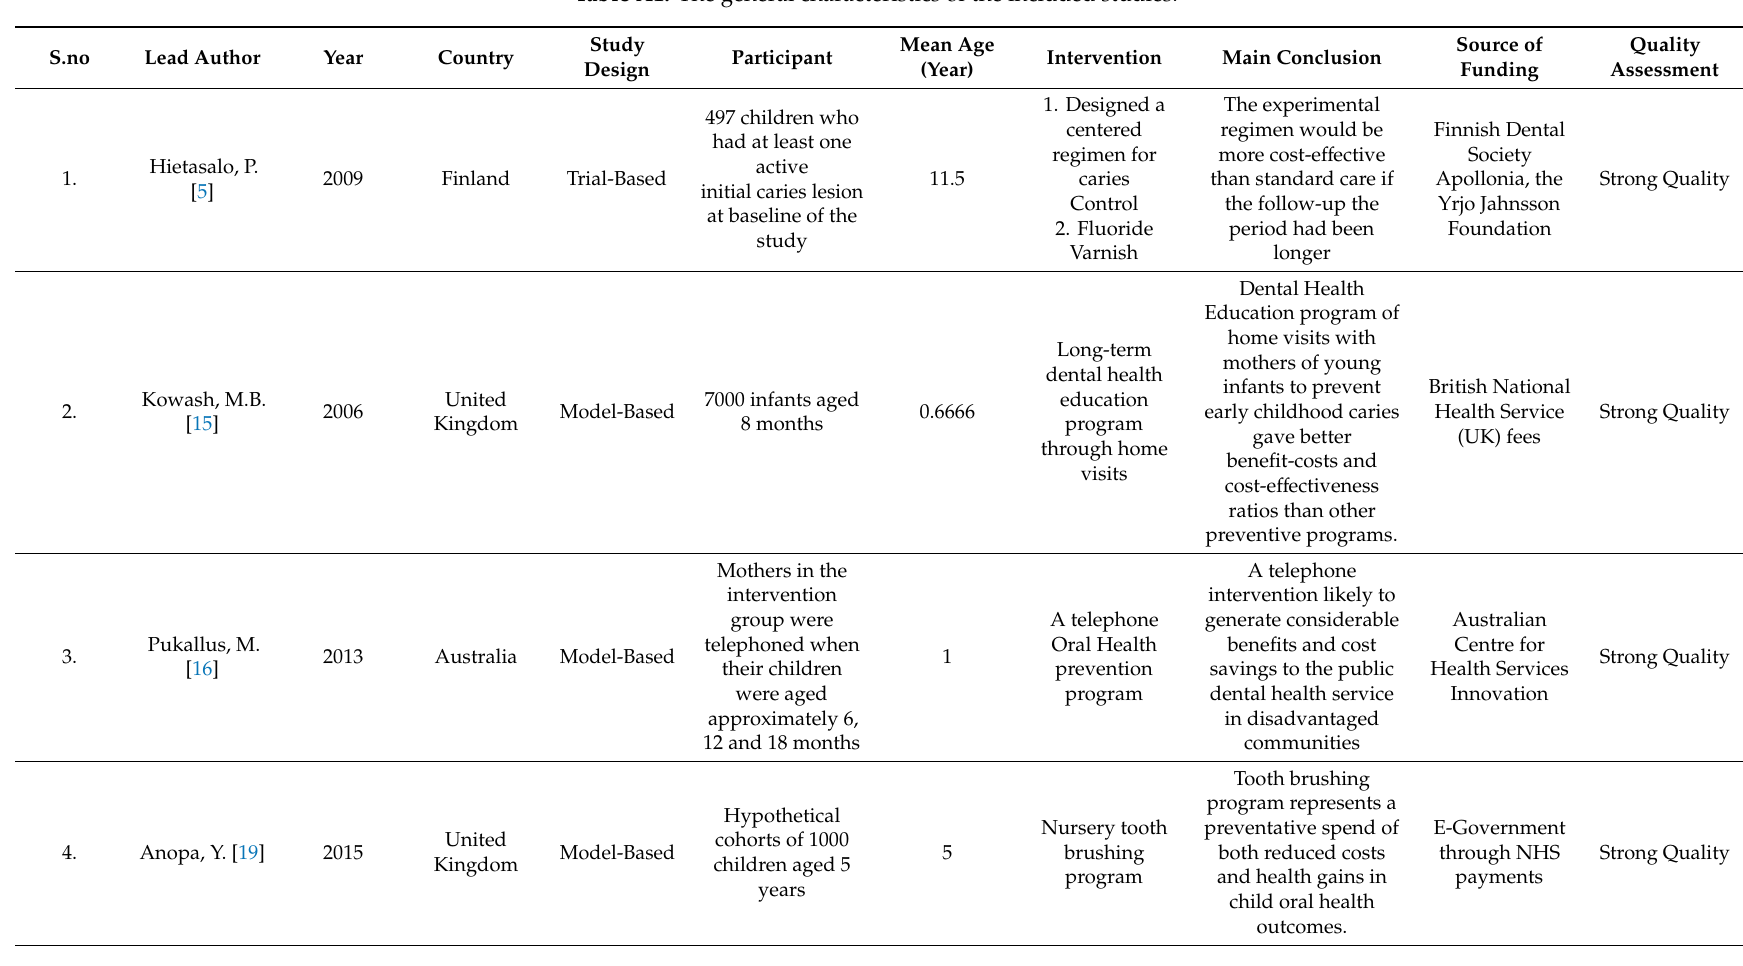
Table A1. The general characteristics of the included